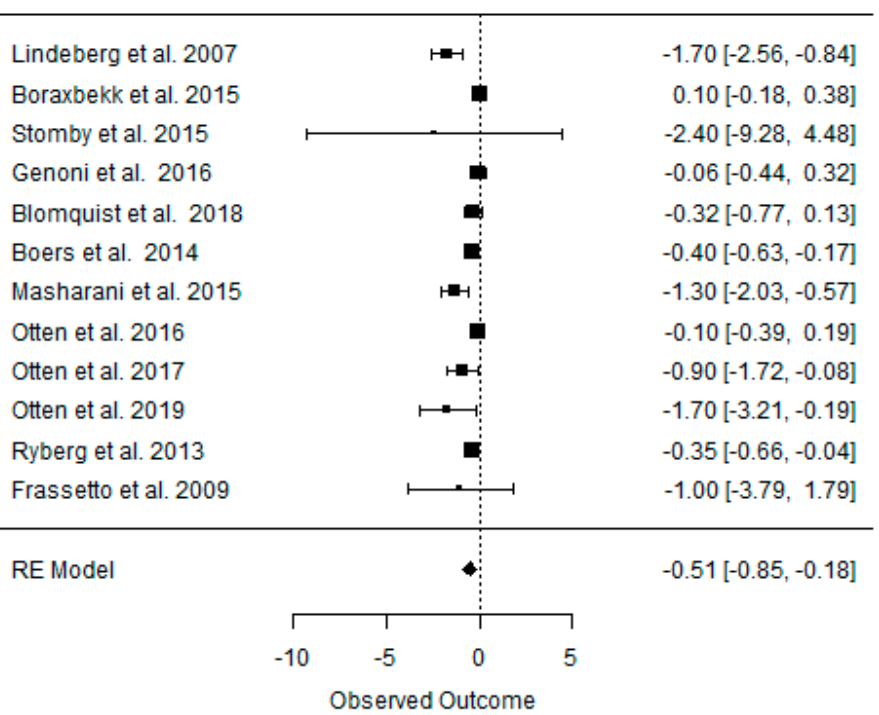
Figure A44. Forest plot of the effect of a PDs on fP glucose (mmol/L) in the short term (weighted mean difference).